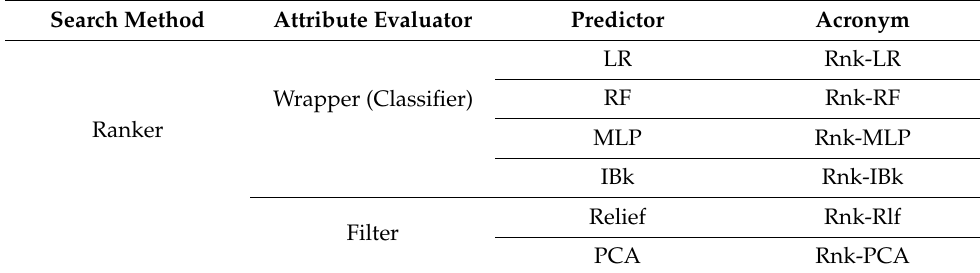
Table 2. Applied Feature Selection